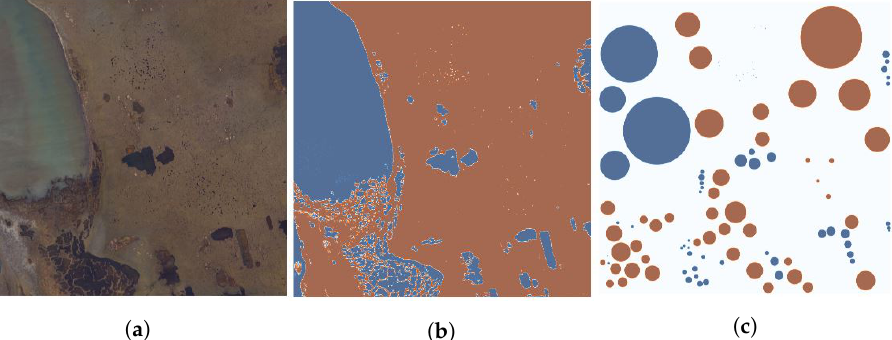
Figure 1. Our proposed method learns from sparsely labelled data for land/water segmentation. ( a ) Sample Image; ( b ) Corresponding Dense Labels; ( c ) Corresponding Sparse